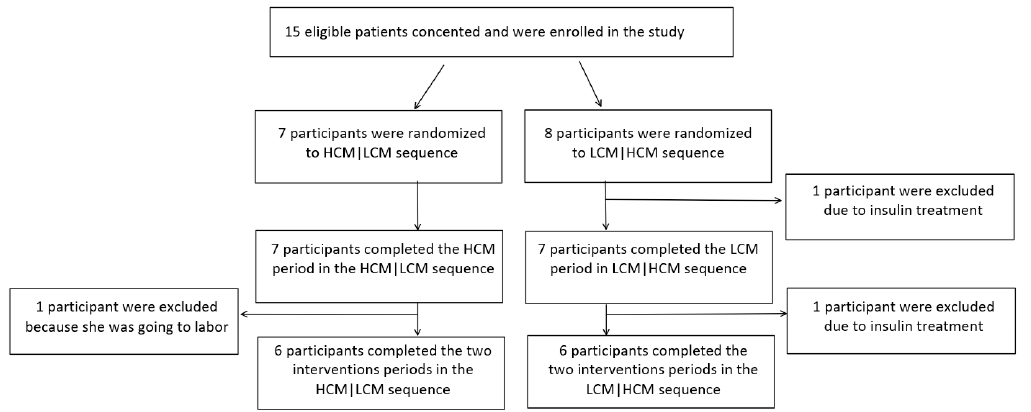
Figure 1. Flow chart of the study. HCM, high carbohydrate and energy content in the morning; LCM, low carbohydrate and energy content in the morning.